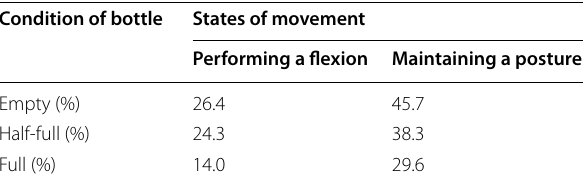
Table 7 Reduction rate of the RMSE Condition of bottle States of